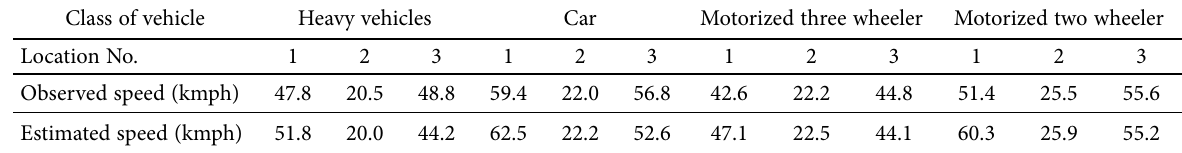
Table 3. Validation of the proposed speed-volume models Class of